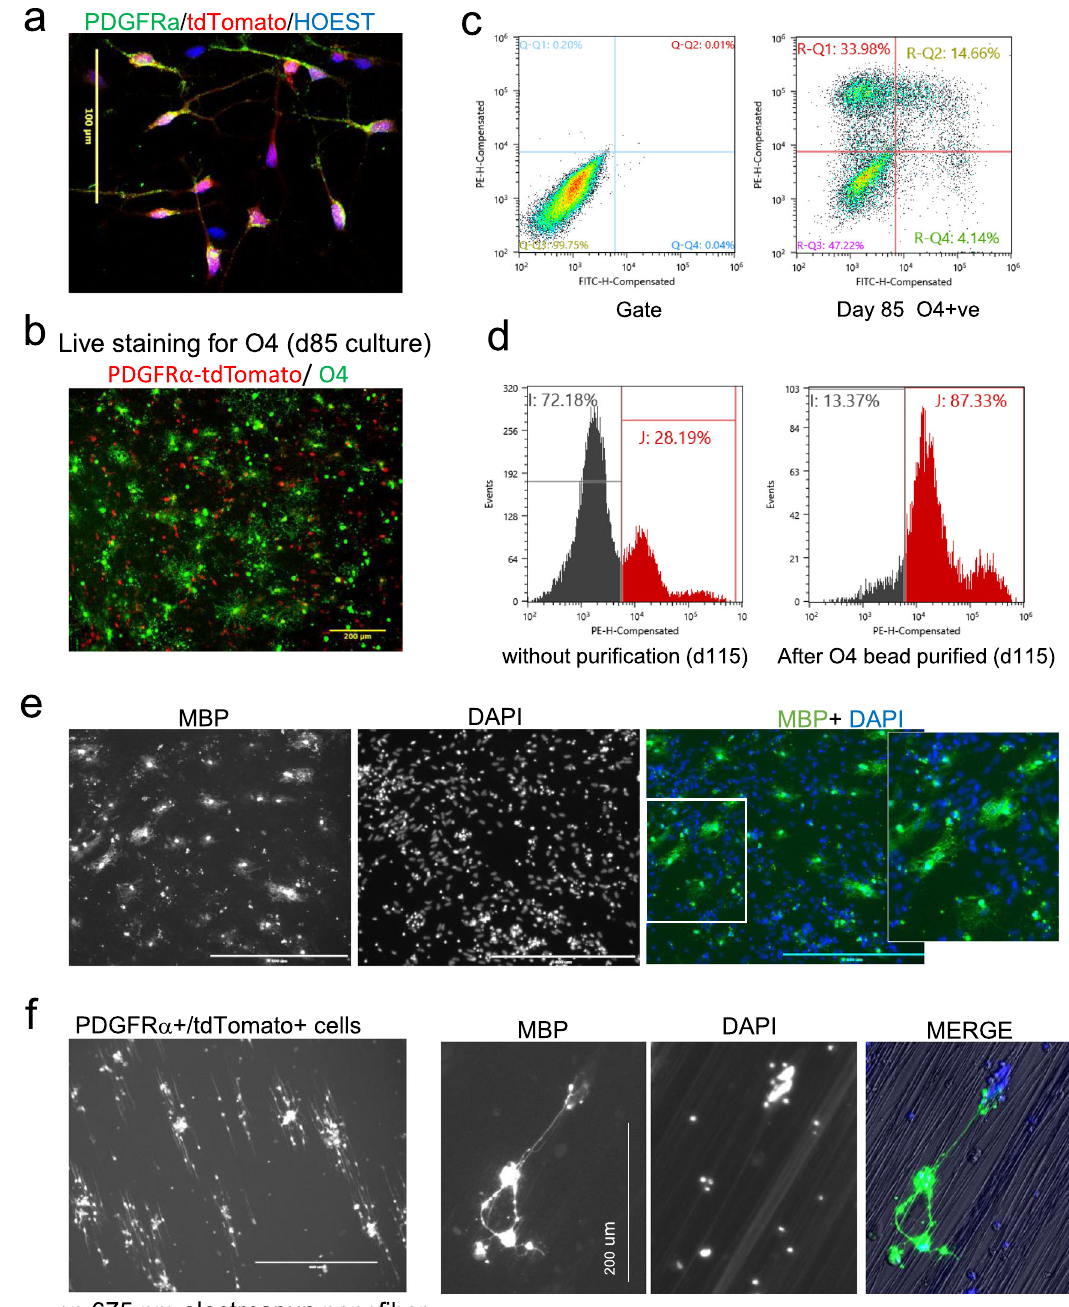
Fig. 3 Maturation of reporter OPCs into myelinating oligodendrocytes. a Image taken with ×40 objective shows PDGFR α localized to the cell membrane and tdTomato in the cytoplasm. Images for individual channels are included in Supplementary Fig. S3c. Scale bar: 100 μ m. Immunohistochemistry with PDGFR α was independently repeated three times with similar results. b Live-cell immuno fl uorescence staining shows that the differentiating reporter OPCs (red) at day 85 express O4 antigen (green). Scale bar: 200 μ m. This was independently repeated three times with similar results. c Flow-based quanti fi cation of the imaged cells shows ~18% O4 + cells, of which ~14% are also tdTomato + . d Flow analysis of tdTomato expression of day 115 before (left) and after (right) MACS-based immunopuri fi cation using O4-antibody-conjugated microbeads. After puri fi cation, the population was enriched to 87% tdTomato + cells. PE is X axis represents PDGFR α -tdTomato. The same gate (left panel of c ) was used for both c and d fl ow analysis. Gating strategy is further detailed in Supplementary Fig. S1j and described in the “ Methods ” section. e , f Day 80 Thy1.2 puri fi ed population of tdTomato enriched cells were further cultured on PLO-laminin-coated plates ( e ) or on electrospun nano fi bers of 675 nm diameter ( f ). e Scale bar: 400 μ m, f left panel, scale bar: 400 μ m. Cultures were grown in mitogen-free media for 3 weeks and immunostained with MBP antibody. e Independently repeated fi ve times and f was independently repeated twice with similar